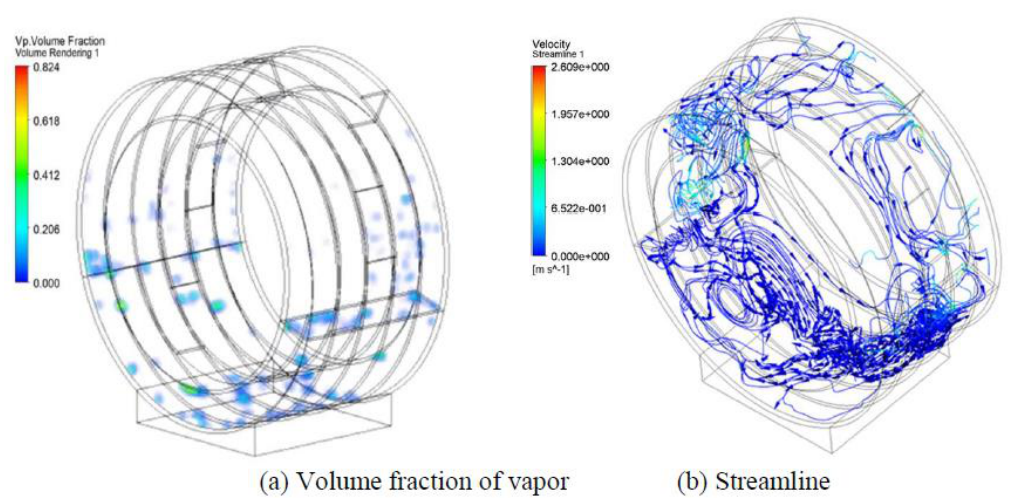
Figure 18. Volume fraction contour; D + = 1.3, L = 50 mm, Model ‘C’, CAHP.